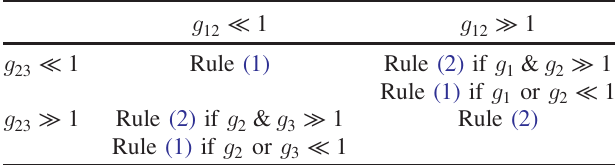
TABLE I. Summary of RG rules. Derivations are given in Appendix